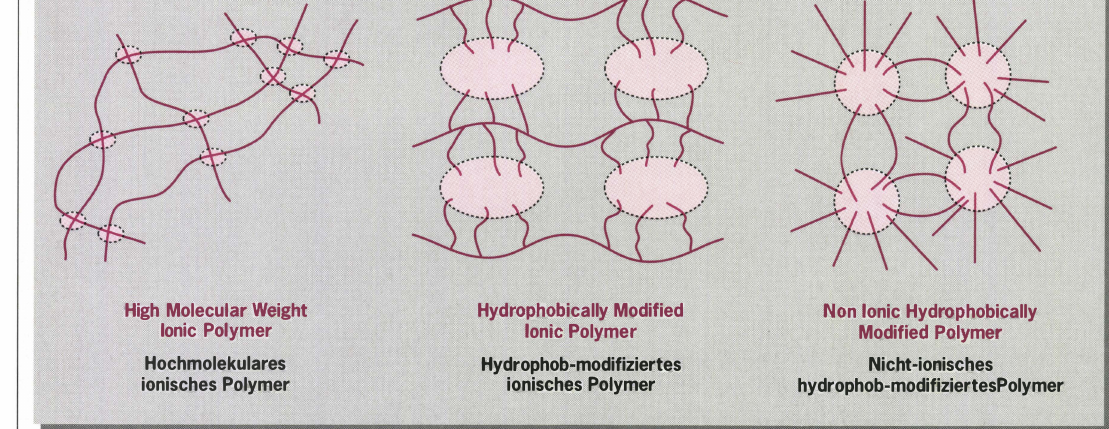
High Molecular Weight Ionic